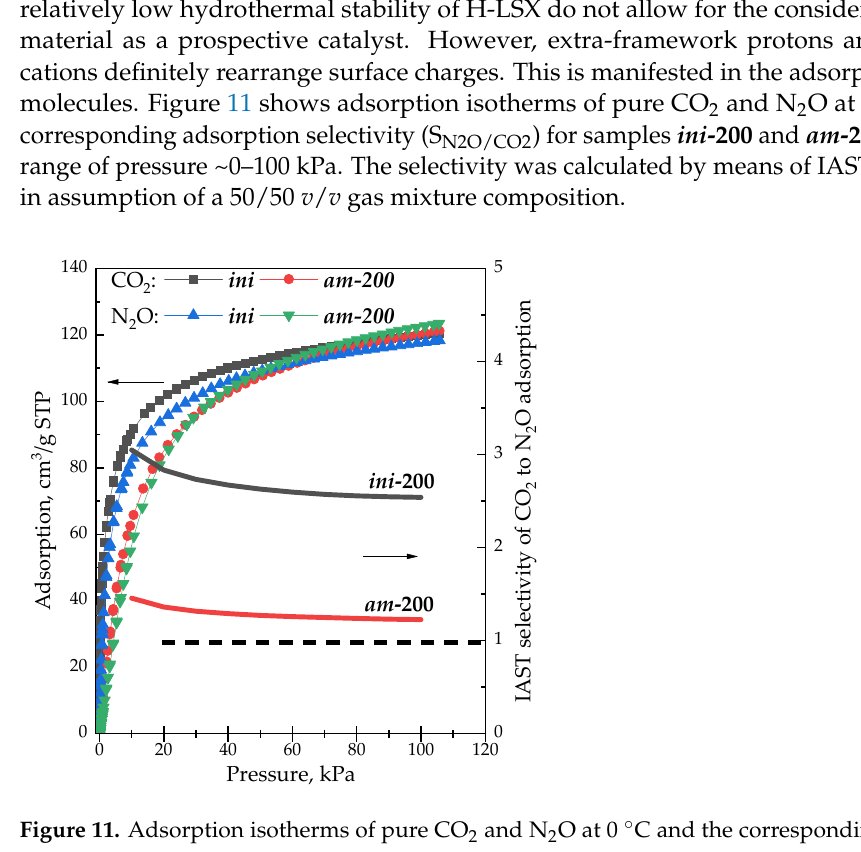
Figure 11. Adsorption isotherms of pure CO 2 and N 2 O at 0 °C and the corresponding adsorption IAST selectivity for samples ini -200 and am -200 .